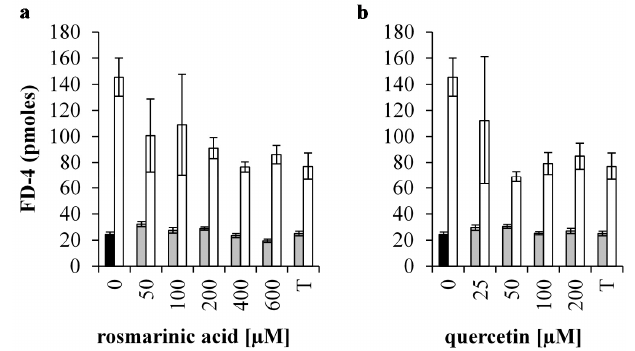
Figure 3. Membrane permeability of H 2 O 2 treated IPEC-J2 cells pre-treated with antioxidants. The permeability of the monolayer is reported as the amount of FD-4 (pmoles) measured in the basal compartment of the Boyden chamber of unstressed and H 2 O 2 treated IPEC-J2 cells ( black bar: untreated control cells, grey bars: no incubation with oxidative stress; white bars: cells stressed by 1 mM H 2 O 2 ) after treatment with ( a ) RA and ( b ) Que. Both antioxidant pre-treatments were compared with 2 mM Trolox (T). Results are presented as means ± S.E., n = 2.